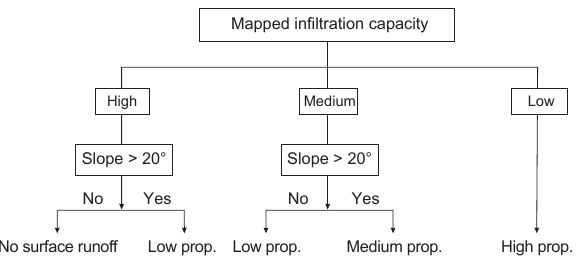
Figure 4. Decision tree for assigning the propensity index to the mapped polygons of infiltration